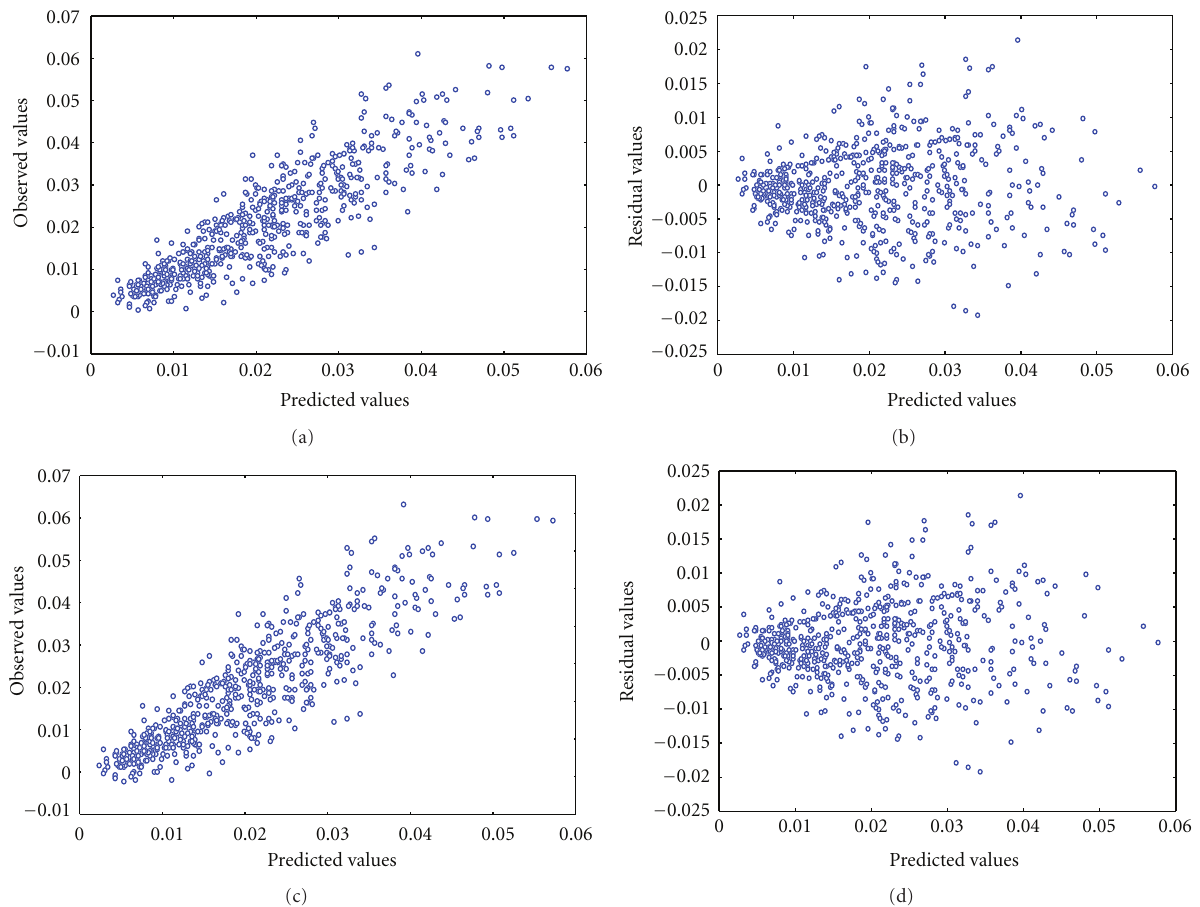
Figure 3: Comparison of observed versus predicted values (a) and the disposition of residuals (b) for the fit of the allometric model for whole developed leaves (leaf-3) in Punta Banda data. Corresponding comparison of observed versus predicted values (c) and the disposition of residuals (d) for the fit of the isometric model for whole developed leaves (leaf-3) in Punta Banda data.